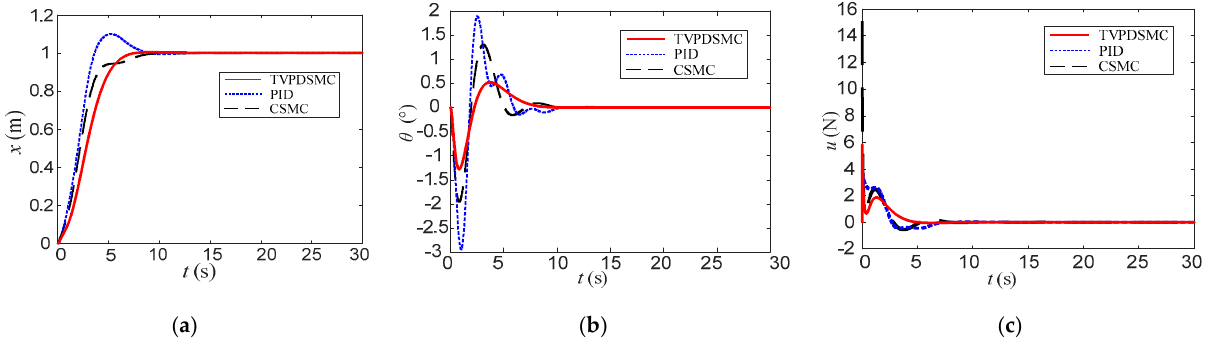
Figure 6. Simulation 4: System state variable response curve. ( a ) Trolley Displacement; ( b ) Payload Swing angle; ( c ) Driving force.